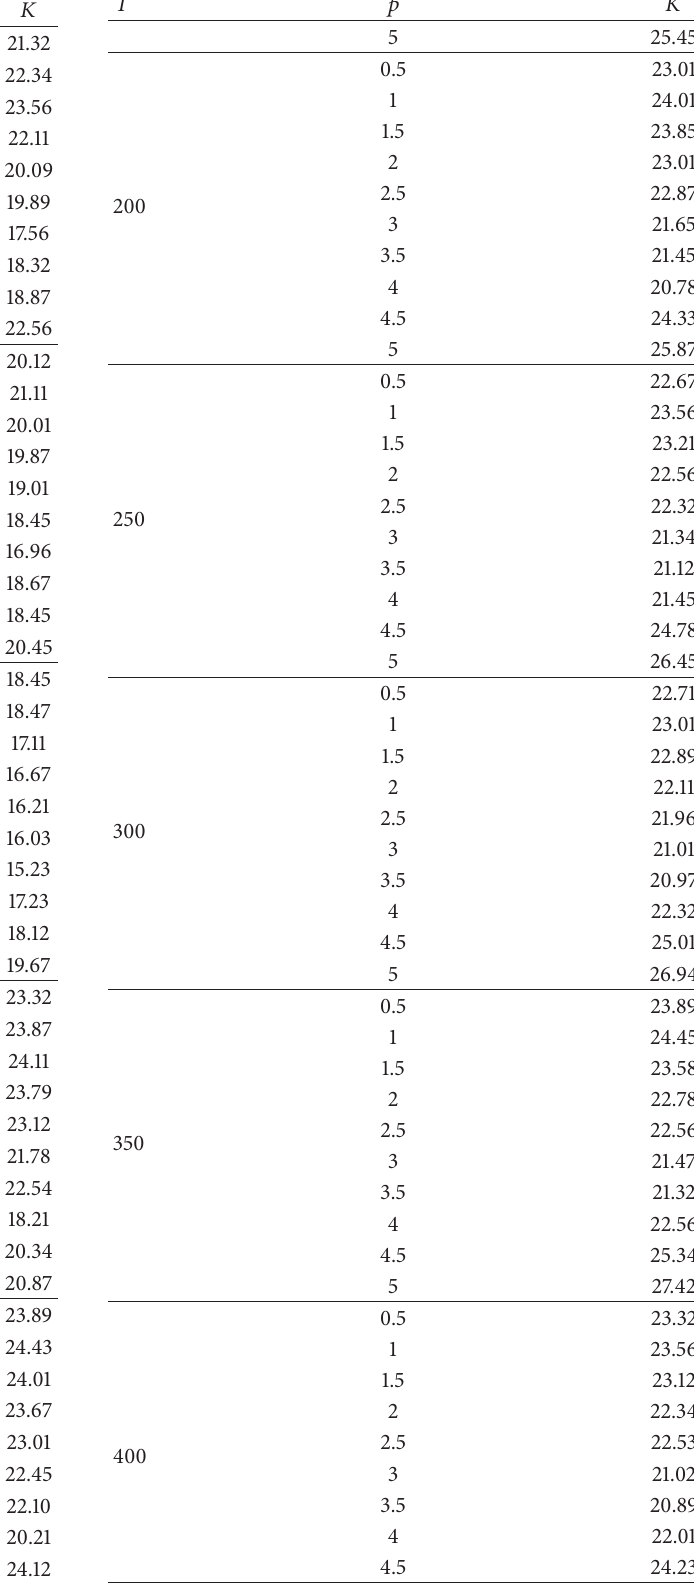
Table 3: Permeability at different temperatures and pore